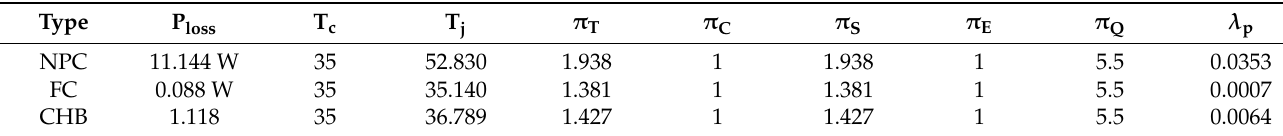
Table 7. The calculated base failure rates for diodes.